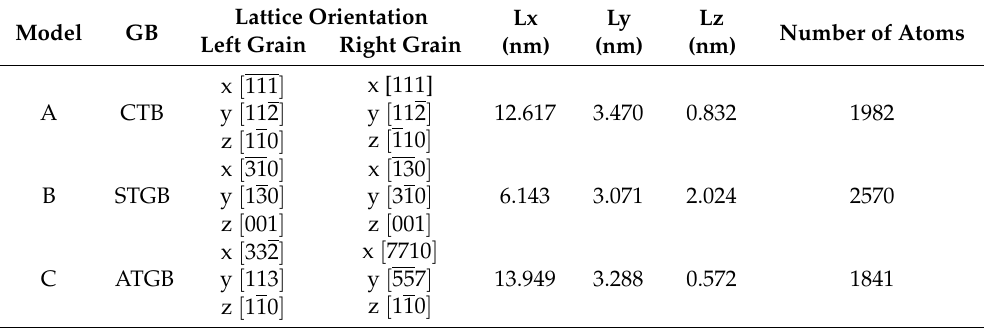
Table 2. Detailed model parameters of the bicrystalline model.